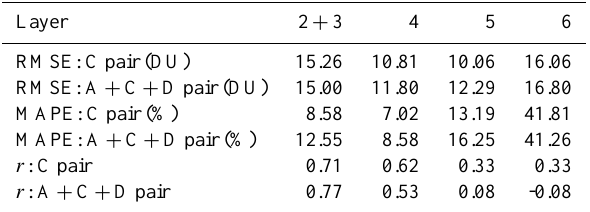
Table 3. Time series validation